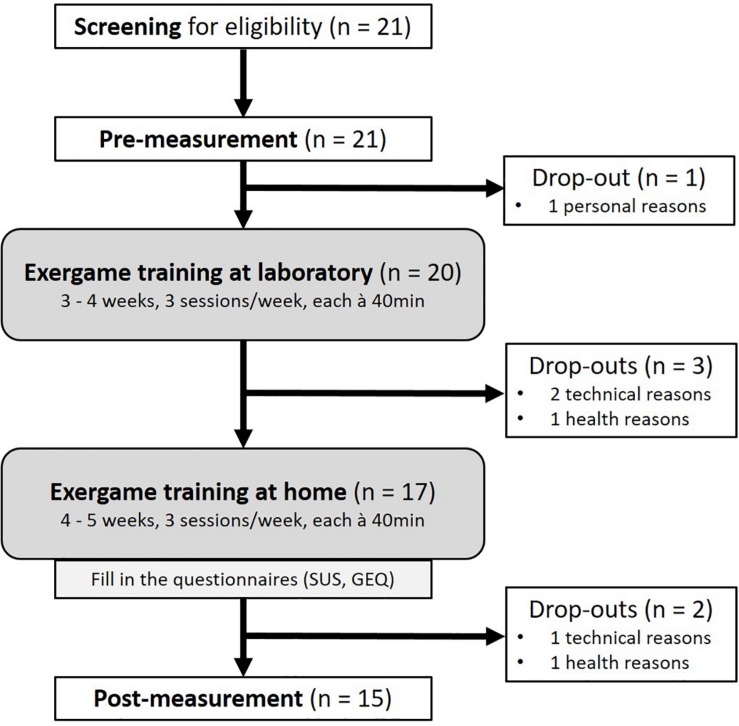
Study flow chart. Screening of participants for eligibility included an assessment of cognitive and health state. Physical and cognitive functions as well as brain activity were measured at pre- and post-measurement. Assessments and the first half of the intervention were performed at the living lab of ETH Hönggerberg (Zurich, Switzerland), the second half at participants’ home. Questionnaires assessing usability and game experience were filled in after the training period. Technical drop-out reasons included software problems, unstable IMU connections and inappropriate movement evaluation. Other drop-out reasons were related to injuries, sudden illness and family affairs. SUS, System Usability Scale; GEQ, Game Experience Questionnaire.